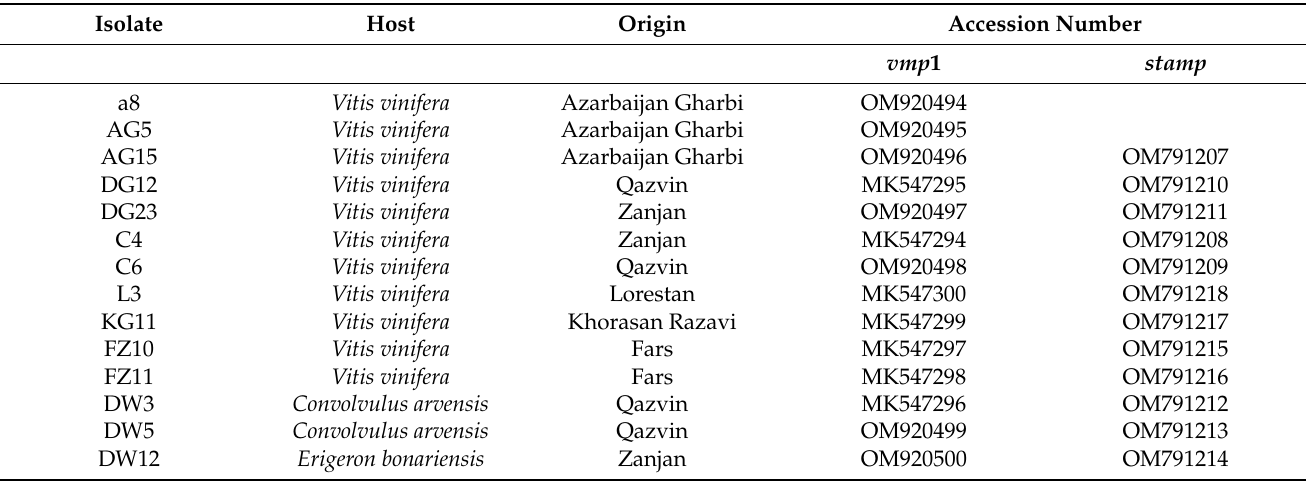
Table 1. ‘ Candidatus Phytoplasma solani’ nucleotide sequences used in the phylogenetic analysis of the vmp 1 and stamp genes from the investigated